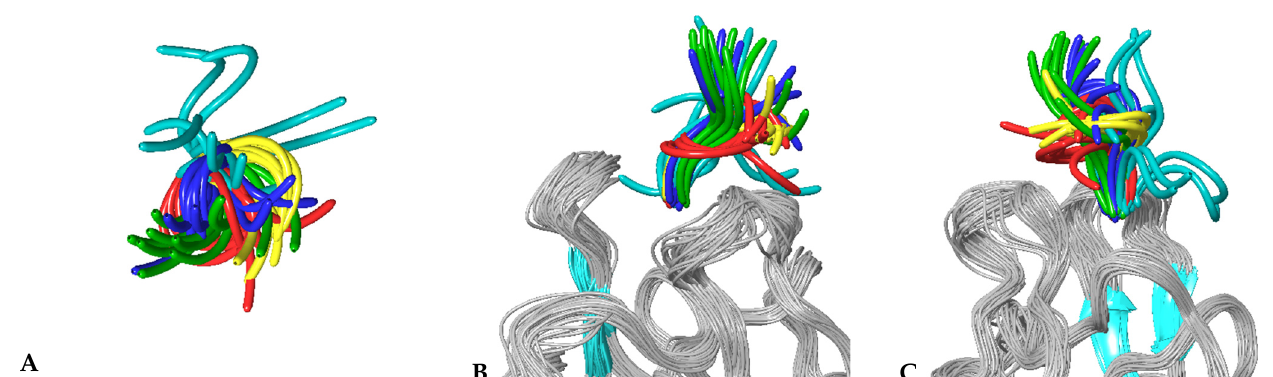
Figure 6. Sampled conformational space of NRP2 peptide complexes. Representative structure of ten most populated clusters obtained from two repeats of 30 ns molecular dynamics simulations were ovelayed for each complex, ( A ) top view, ( B ) side view that corresponds to the orientation of the top view and ( C ) side view rotated by 90°. NRP2 is shown as ribbons with beta strands coloured blue and loops coloured grey. Peptides are denoted by using single colours: C—cyan; B167—blue; B186—yellow; A165—green and control red.